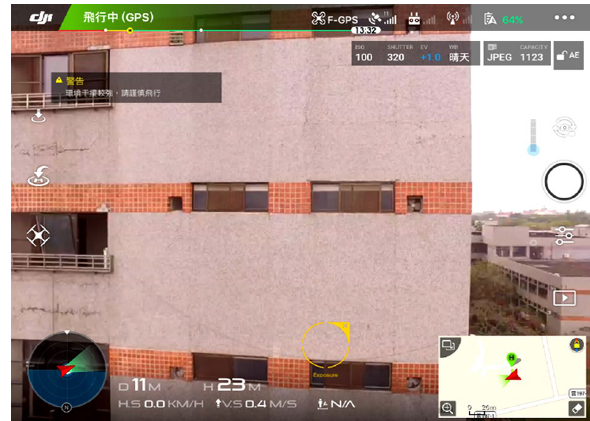
Figure 7. The sample image taken from ground side-shot